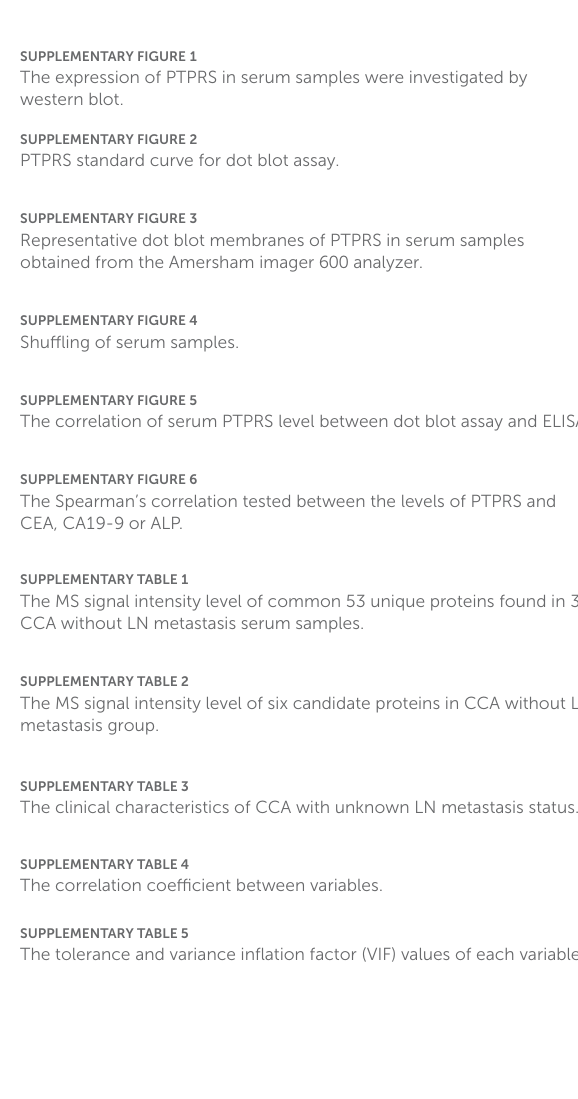
SUPPLEMENTARYTABLE3 The clinical characteristics of CCA with unknown LN metastasis status.